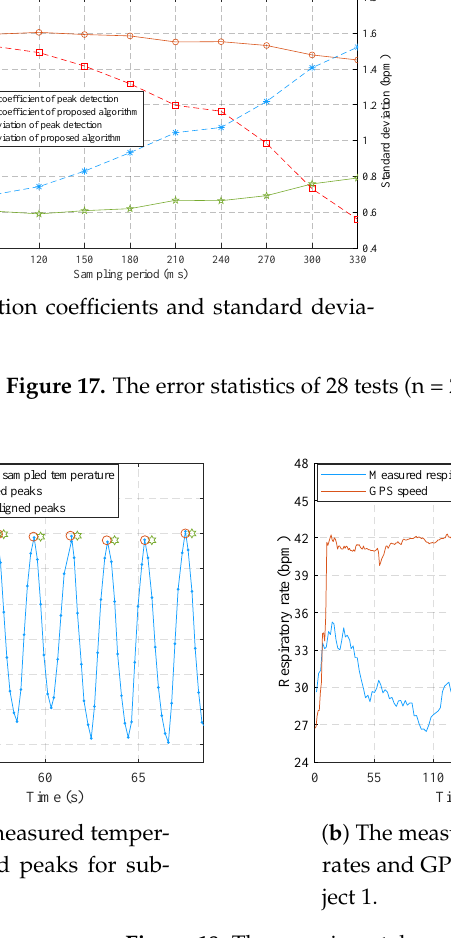
Figure 18. The experimental results of 10 tests in movement mode.